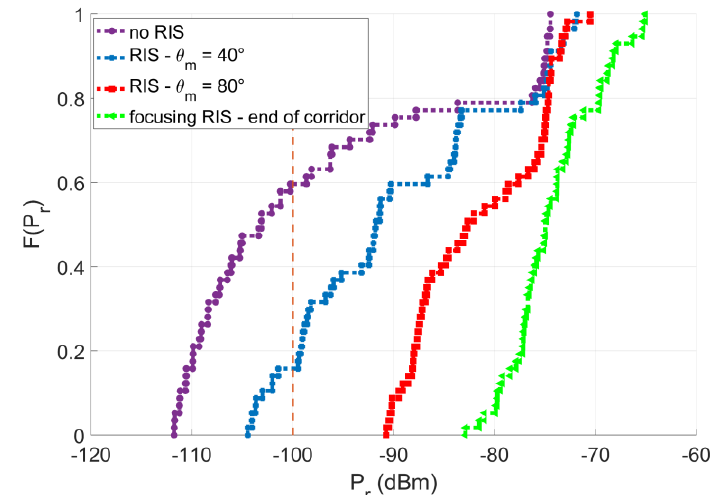
Figure 8. CDF of the received power for different RIS configurations.